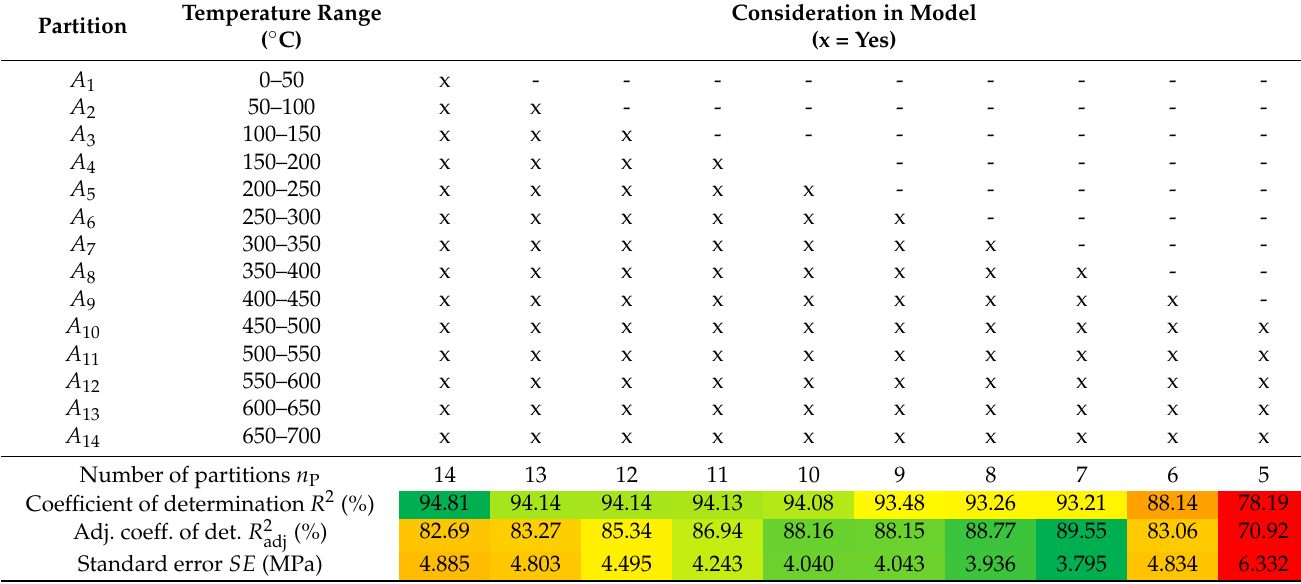
Figure 11. ( a ) Thermal history of Geo-i at evaluation point Q, ( b ) enlarged section of the thermal history with area under the time temperature curve subdivided into partitions A 1 –A 8 of width ∆ T = 100 °C. Table 3 shows the statistical evaluation parameters coefficient of determination R 2 , adjusted coefficient of determination R 2 and standard error SE for the several linear multiple regressions performed with ∆ T P = 50 ◦ C, “x” indicating which partitions and therefore temperature ranges were considered in the respective regression model. Table 3. Series of multiple linear regression studies between ultimate tensile strength and partitions from simulated thermal history with varied number of partitions considered, red coloring means lowest value and green coloring means highest value of the respective value per row.